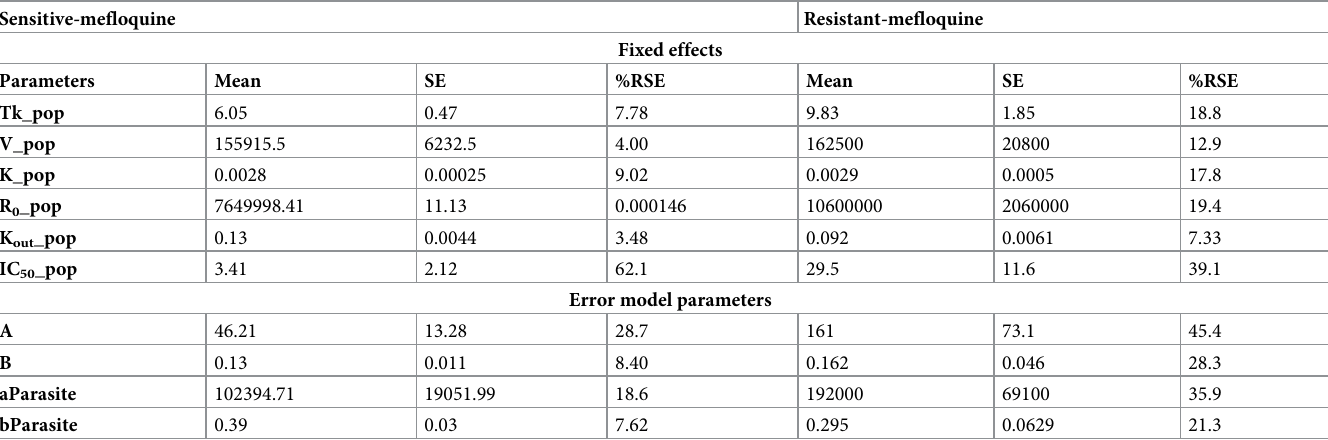
Table 1. Pharmacokinetics/pharmacodynamics parameters.